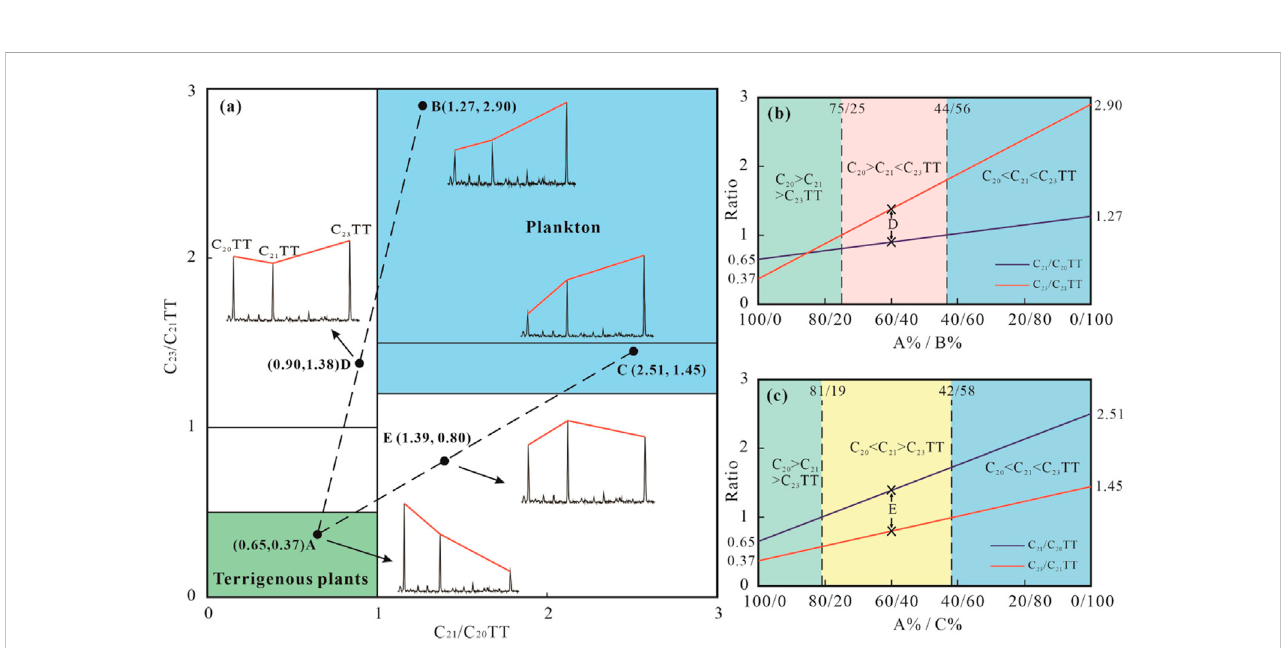
FIGURE 4 NumericalsimulationfortheoriginofC 20 -C 21 -C 23 tricyclicterpane(TT)abundancepatternsbymixingplanktonandterrigenousplants atvariousmixing ratios.Points (A – C) aretherepresentativeend-memberC 20 -C 21 -C 23 TTdistributionsforthemixingmodeling.WiththechangeofmixingratiosbetweenAand B (C), the C 20 -C 21 -C 23 TT abundance pattern changes along Line A-B (C). Points D and E are the representative C 20 -C 21 -C 23 TT abundance patterns of A-B mixture and A-C mixture,